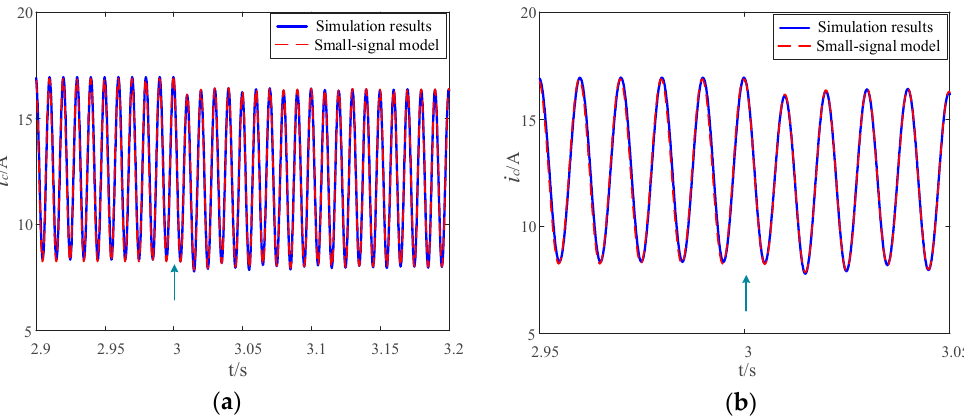
Figure 8. Step response comparison of i c ( t ) with open-loop control mode. ( a ) Zoom-out view of i c ( t ). ( b ) Zoom-in view of i c ( t ).